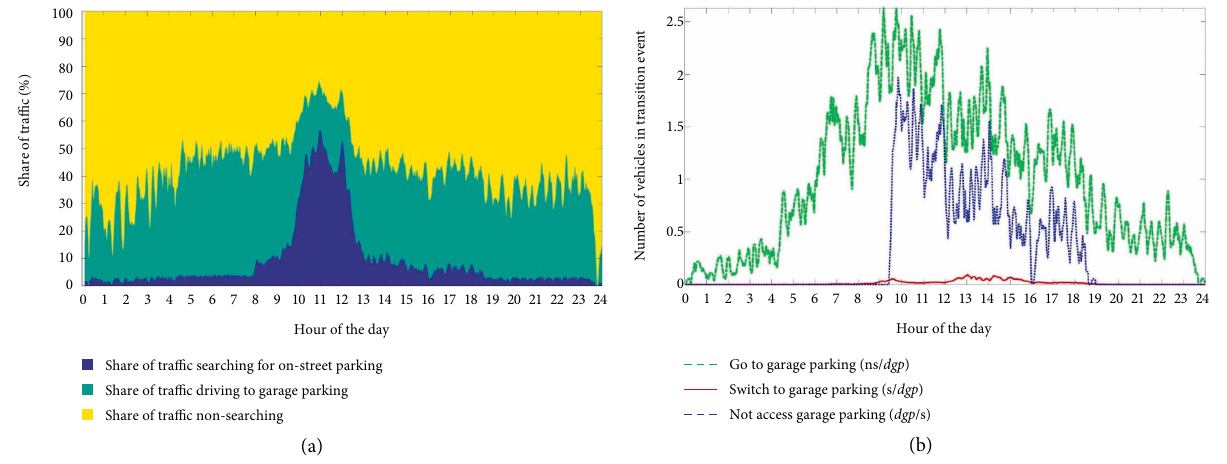
Figure 9: Traffic composition and garage parking-related transition events as a moving average over Vehicles in garage parking related transition events.